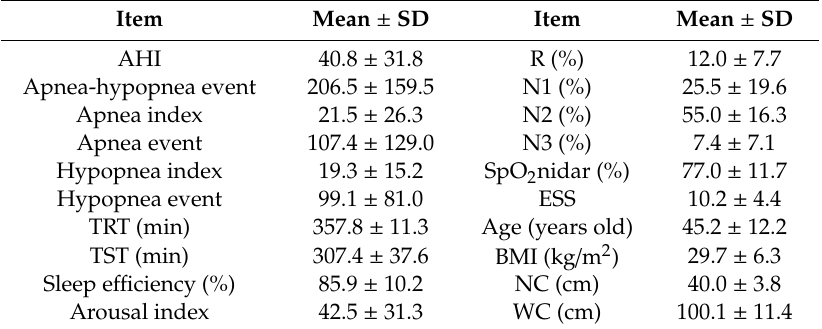
Table 1. Basic characteristics of enrolled participants (N = 60; female / male = 3 / 57).